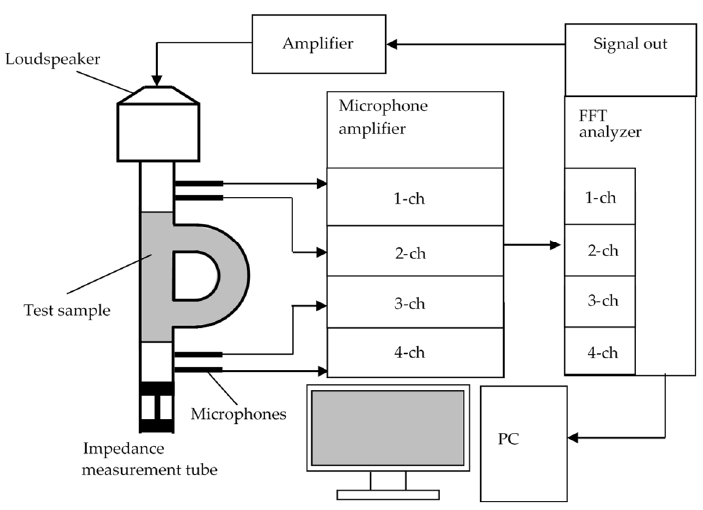
Figure 1. Schematic of the impedance measurement tube and measurement equipment.